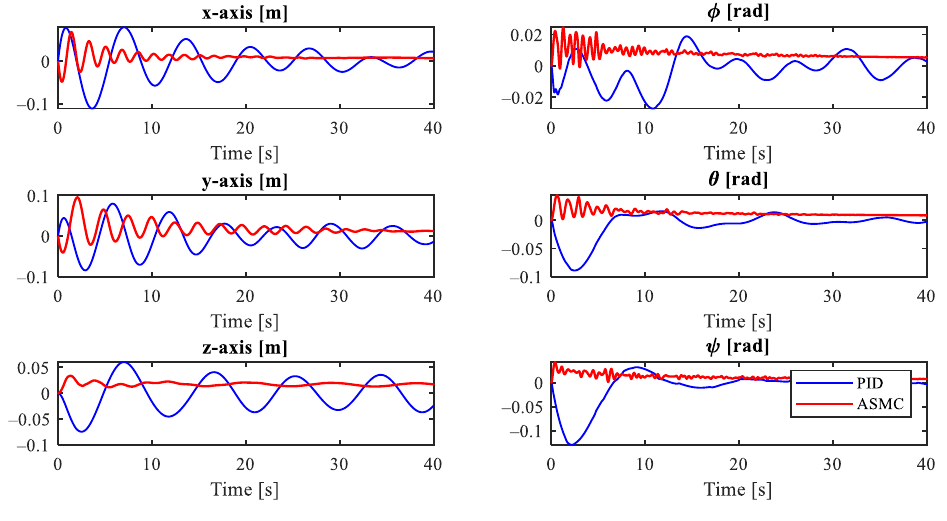
Figure 12. Tracking errors in the retrieving stage.